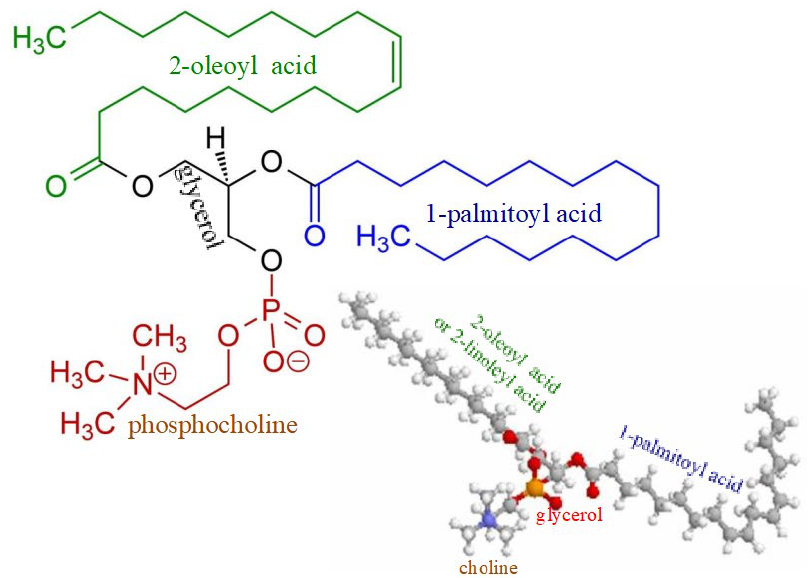
Figure 3. Chemical structure of phosphatidylcholine containing palmitic and oleic fatty acids.